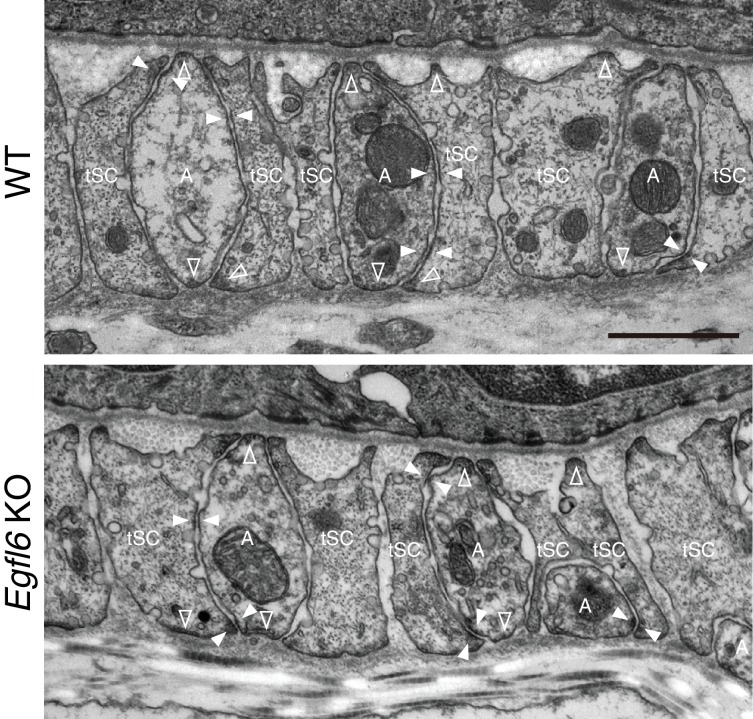
Ultrastructural examination of lanceolate complexes in wild-type and Egfl6 knockout mice.Transmission electron microscopic images of the upper-bulge of P35 zigzag hair follicles of wild-type and Egfl6 knockout mice. Electron-dense plaques, characteristic structures for cell–ECM and cell–cell adhesions, are indicated by open arrowheads (cell–ECM adhesion sites) and closed arrowheads (cell–cell adhesion sites). A, axon; tSC, terminal Schwann cell. Scale bar, 1 μm.